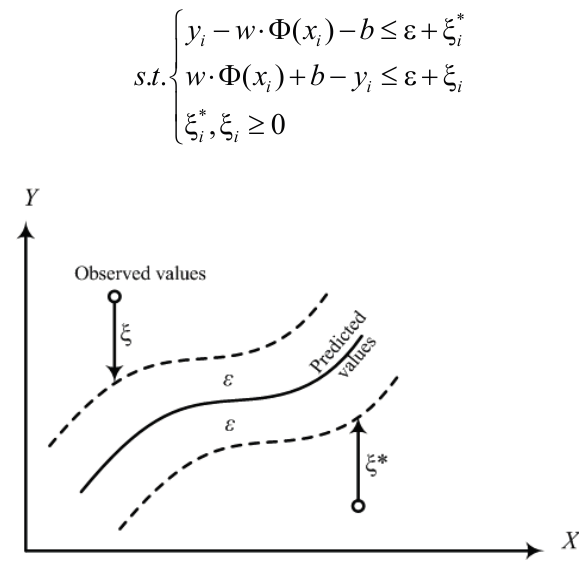
Figure 2. The parameters for